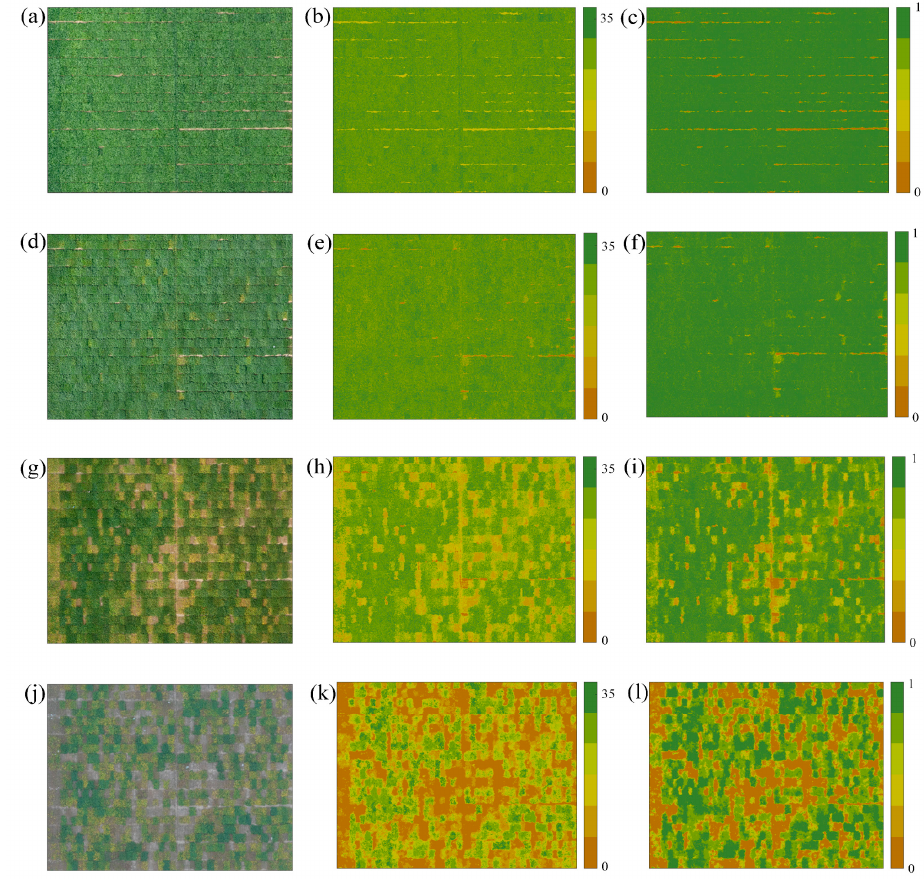
Figure 9. Full-period UAV RGB images with LCC and FVC spatial distribution maps: ( a , d , g , j ) RGB images of the P1–P4 periods, respectively. ( b , e , h , k ) LCC spatial distribution maps of P1–P4, respec- tively. ( c , f , i , l ) FVC spatial distribution maps of P1–P4, respectively.